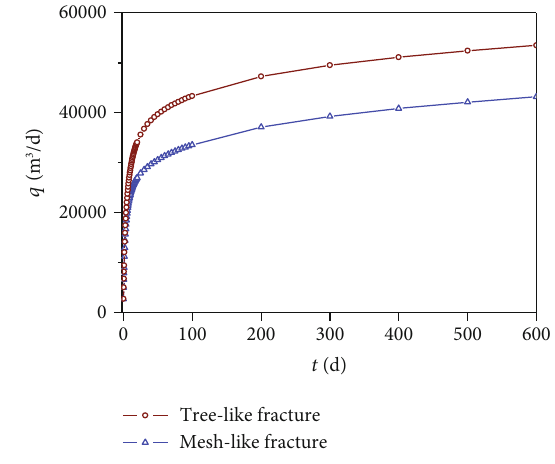
Figure 9: Comparison of the cumulative production for lattice-like and tree-like